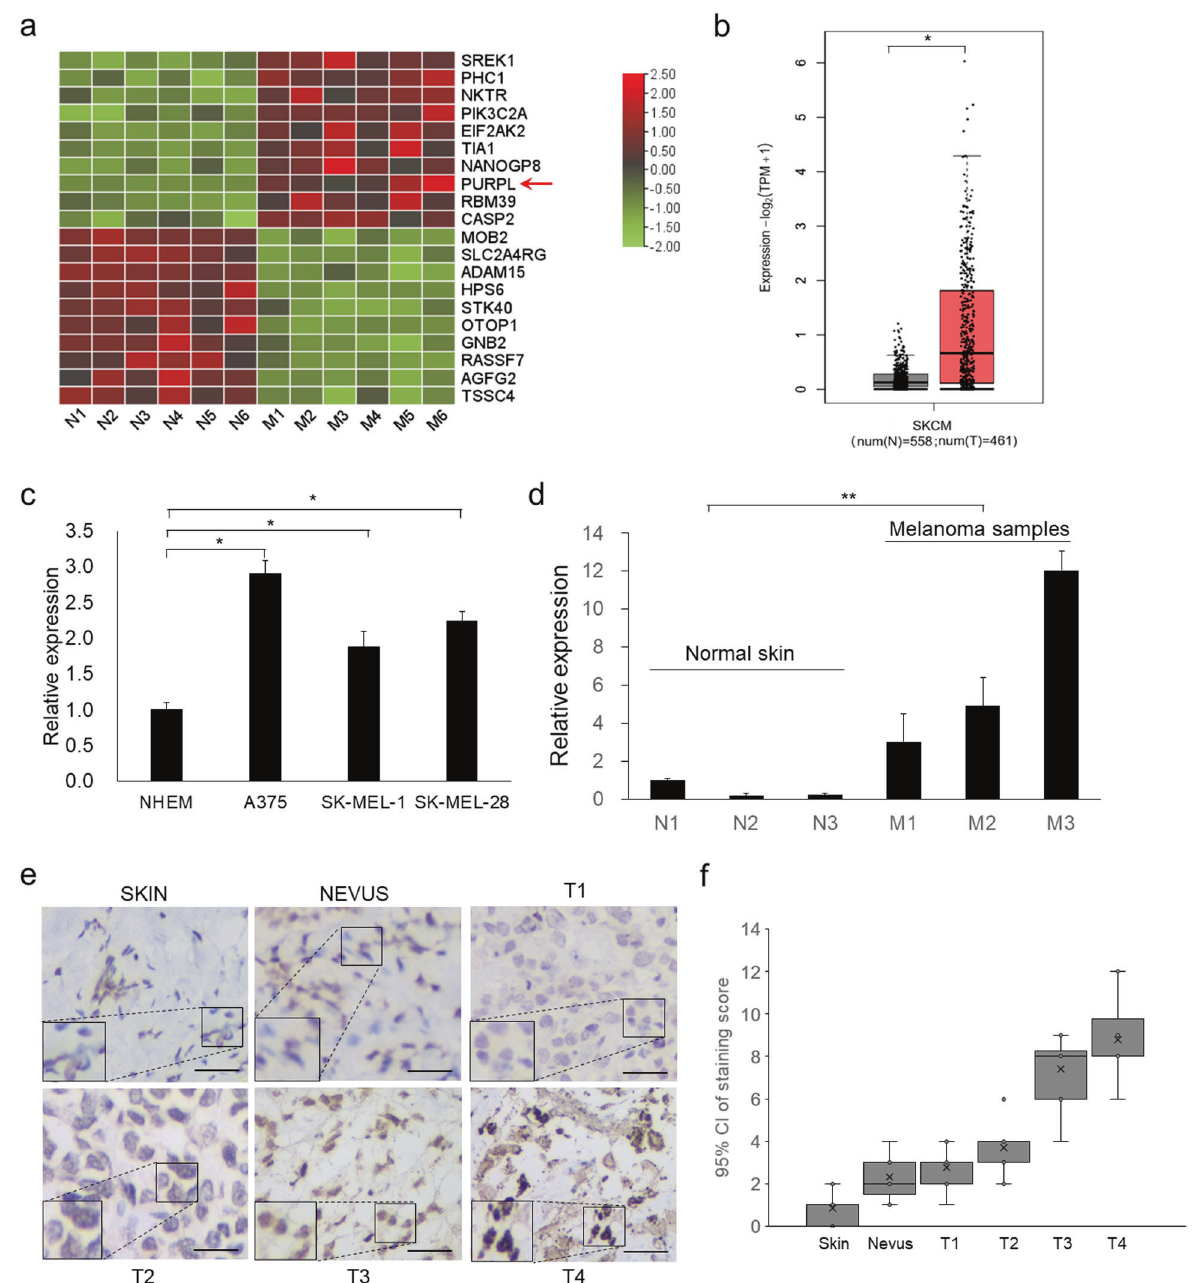
Fig. 1 PURPL is upregulated in melanoma cells and primary tumors and acts as oncogene. a The top 10 upregulated and top 10 downregulated genes in primary melanomas were sorted according to the deviation values and shown in a heat map. Color bars on the right represent ranges of z value. PURPL was indicated by a red arrow. b The expression of PURPL in melanoma (461 cases) compared with normal tissues (558 cases). The original data is from The Cancer Genome Atlas Program (TCGA) database and analyzed by Gene Expression Pro fi ling Interactive Analysis (GEPIA, http://gepia.cancer-pku.cn/). The expression levels of PURPL were detected by qPCR in c primary normal human epidermal melanocytes (NHEM) and melanoma cell lines (A375, SK-MEL-1, and SK-MEL-28) or d normal skin tissues and melanomas. The qPCR data represent the average of three independent experiments ±s.d. e in situ hybridization (ISH) detection of PURPL on paraf fi n sections of melanoma and normal skin specimens. Representative images with various levels of staining (negative or weak from normal tissues, strong from tumor tissues) are shown. Scale bar: 100 µm. f Association of PURPL staining scores with tumor grade (Normal skin tissues, Nevi, T1, T2, T3, and T4). Data are plotted as the means of 95% con fi dence interval ±s.d. * P < 0.05, ** P < 0.01, *** P < repressed by 3-MA treatment (Fig. 4c). Further, overexpression of To validate if PURPL regulates autophagy, we treated PURPL signi fi cantly inhibited the formation of LC3 foci induced melanoma cells with autophagy inhibitor 3-MA. In addition to by PBS treatment-mediated starvation (Fig. 4d, e), which is the decrease of LC3 foci positive cells in control group, 3-MA consistent with the less generation of LC3B-II in PURPL- treatment could signi fi cantly compromise the number of LC3 overexpressed groups (Fig. 4f). Rapamycin treatment-induced foci positive cells induced by PURPL depletion (Fig. 4a, b). The autophagy could also be suppressed by PURPL overexpression highly upregulated amount of LC3B-II was also consistently